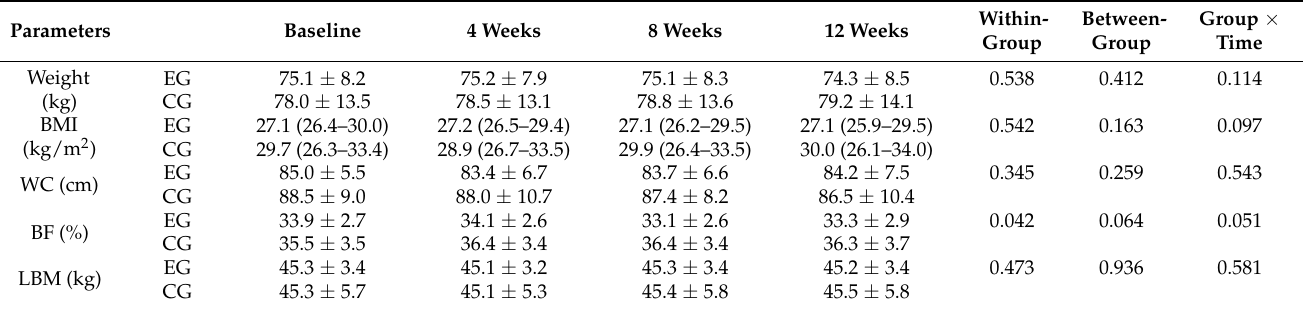
Figure 2. Changes in the percentage body fat and metabolic hormone concentrations from baseline in girls with obesity. ( a ) Body fat (%), ( b ) aclylated ghrelin, ( c ) des-acylated ghrelin, ( d ) GOAT, ( e ) AG/DAG ratio. Data are expressed as medians with interquartile ranges (I bars). Asterisks indicate significant between-group differences over time ( p < 0.05). p -values were calculated by repeated measures ANOVA. AG, acylated ghrelin; DAG, desacylated ghrelin; GOAT, ghrelin O-acyltransferase. Table 2. Changes in anthropometric parameters of the two